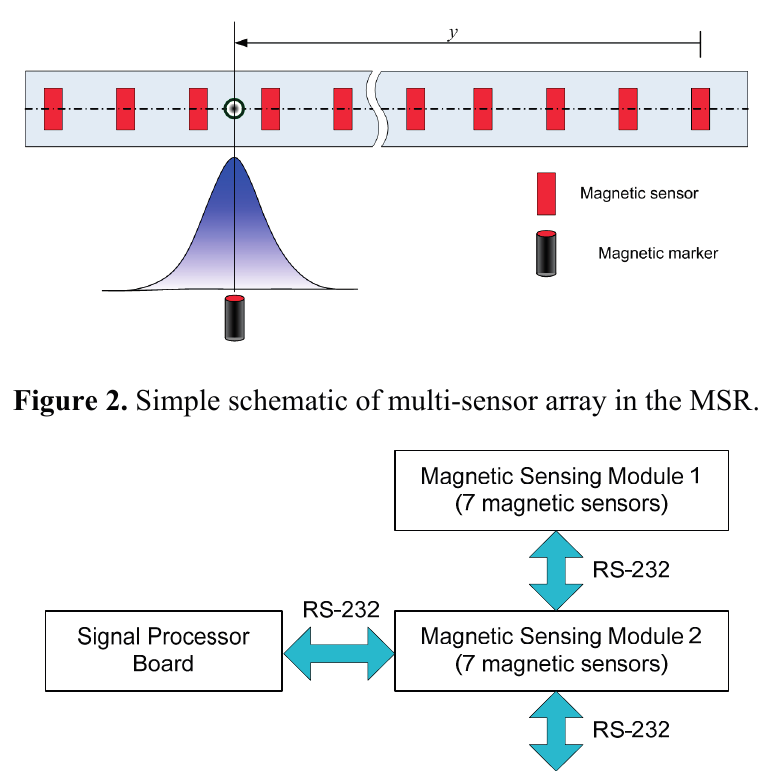
Figure 1. The array of magnetic signals as a series of Gaussian distribution functions in 3D space.